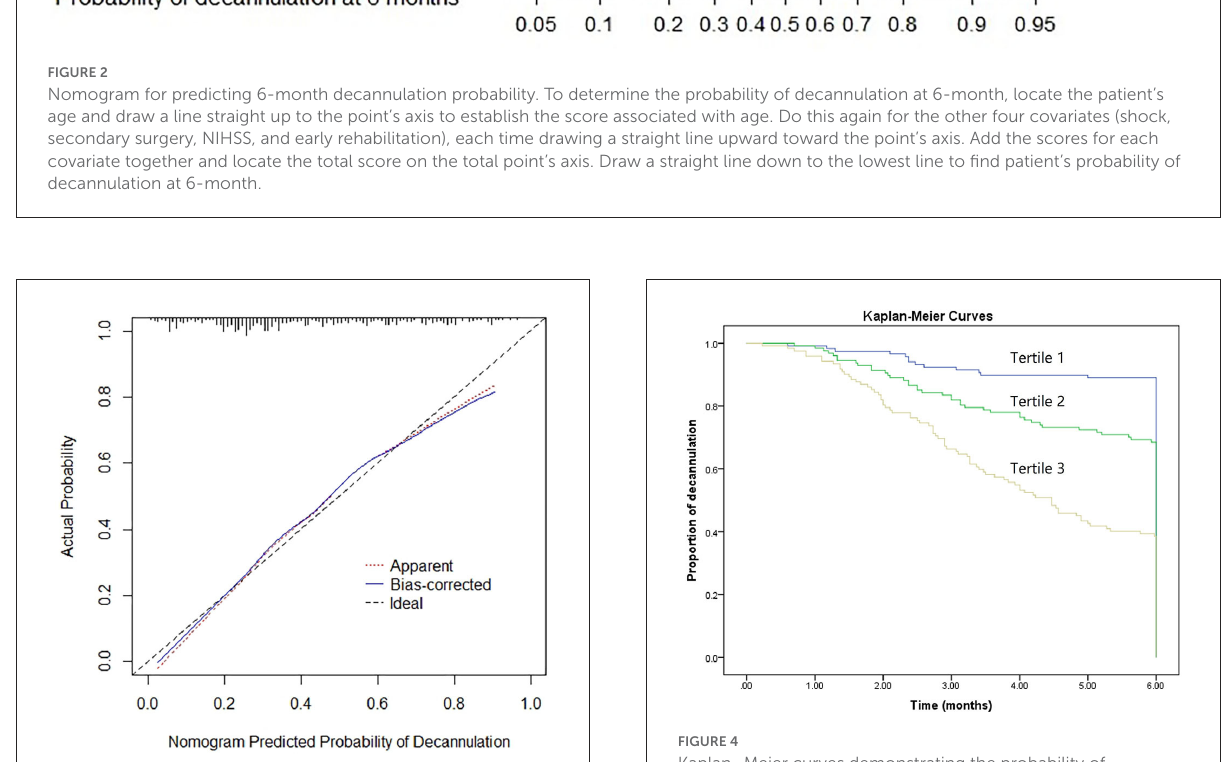
FIGURE4 Kaplan–Meier curves demonstrating the probability of decannulation within 6 months according to tertiles of predicted scores.